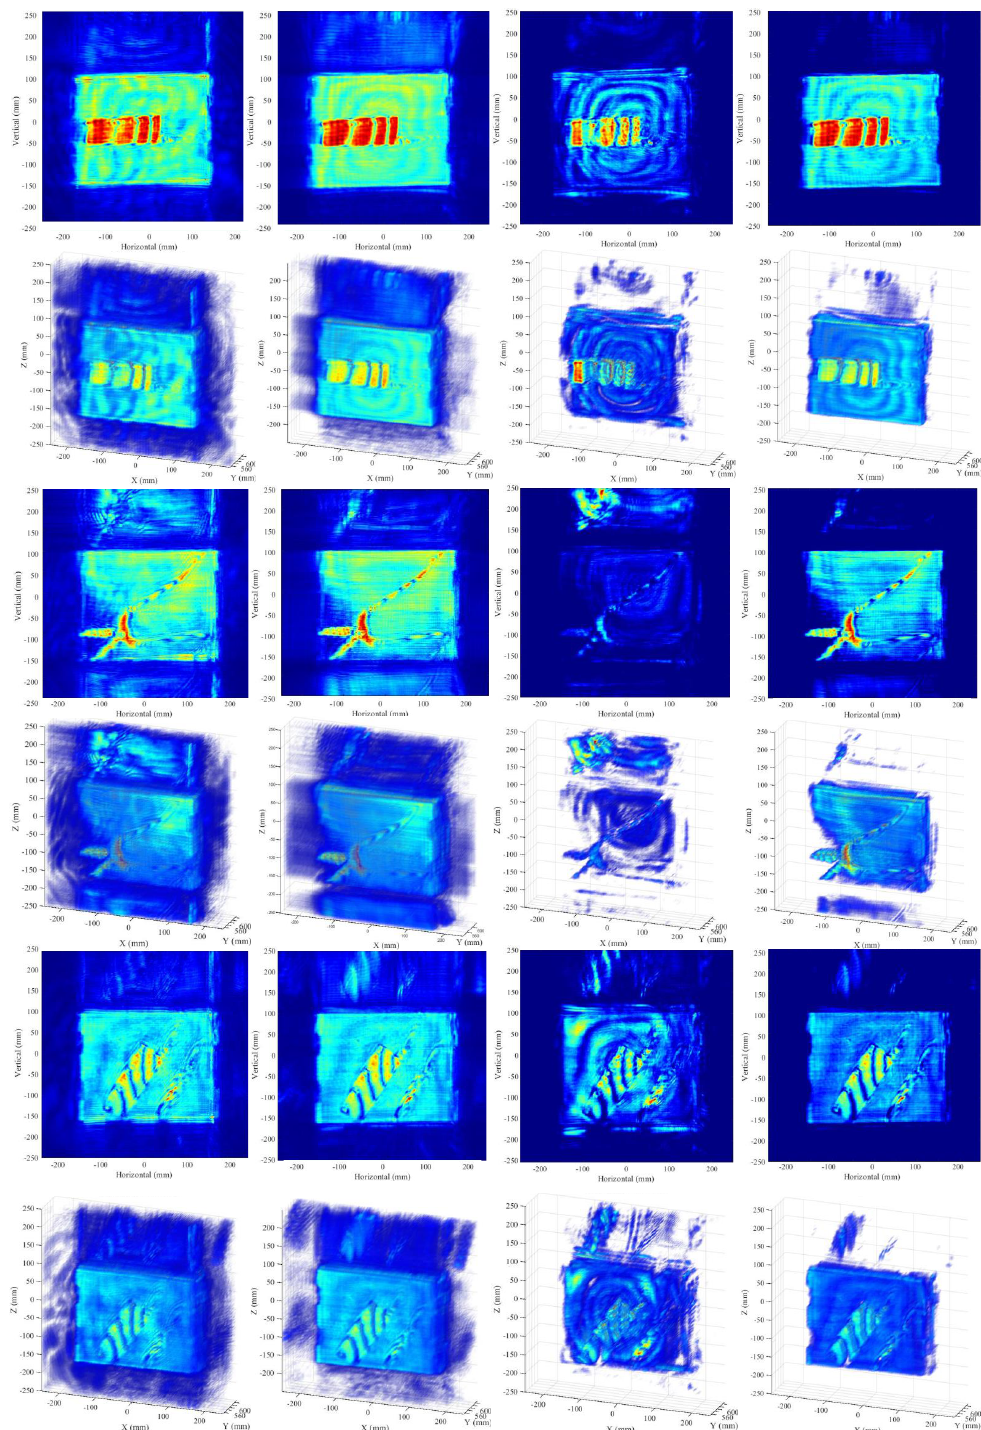
Figure 13. Imaging results of different targets using different algorithms. (Rows 1, 2) are the results of the concealed knife; (Rows 3, 4) are the results of the concealed snips; (Rows 5, 6) are the results of the concealed knives. Rows 1,3, and 5 are the 2-D imaging results; Rows 2,4, and 6 are the 3-D imaging results; Column 1 is the BPA imaging results; Column 2 is the RMA imaging results; Column 3 is the CSA imaging results; Column 4 is the RMIST-Net imaging